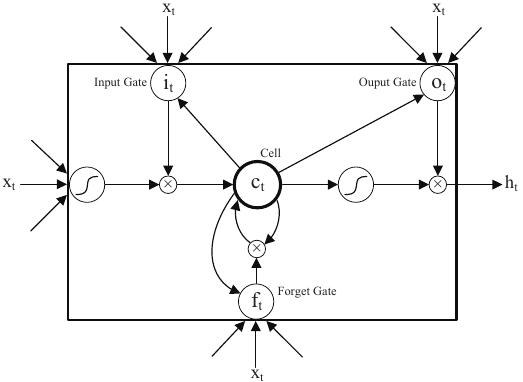
Figure 3. Architecture of the memory block of